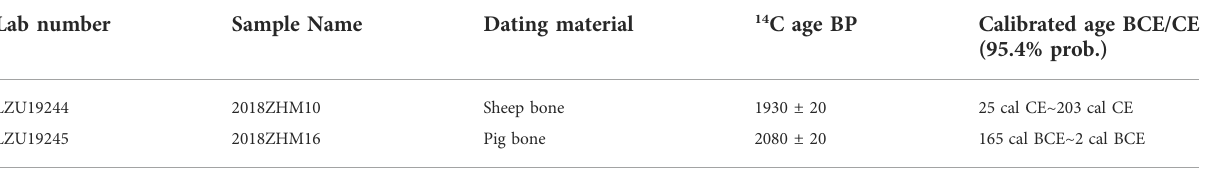
TABLE 3 Calibrated radiocarbon dates for animals from the HSG